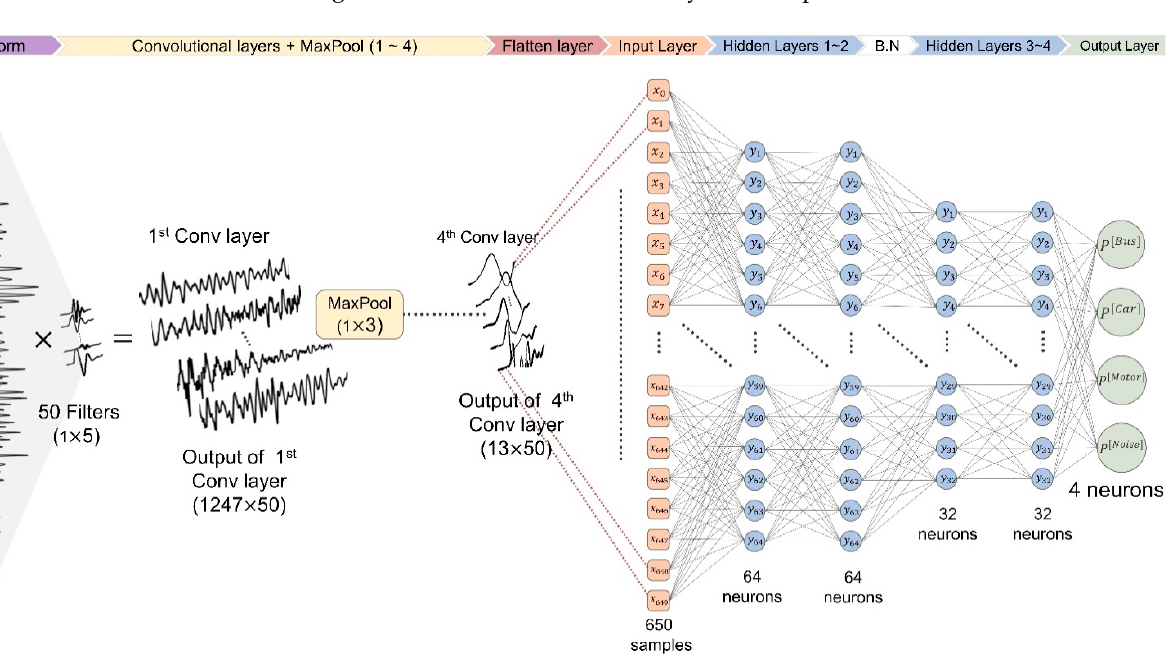
Table S2. We chose four convolutional layers after testing different numbers of layers and considering the trade-offs between accuracy and computational time.